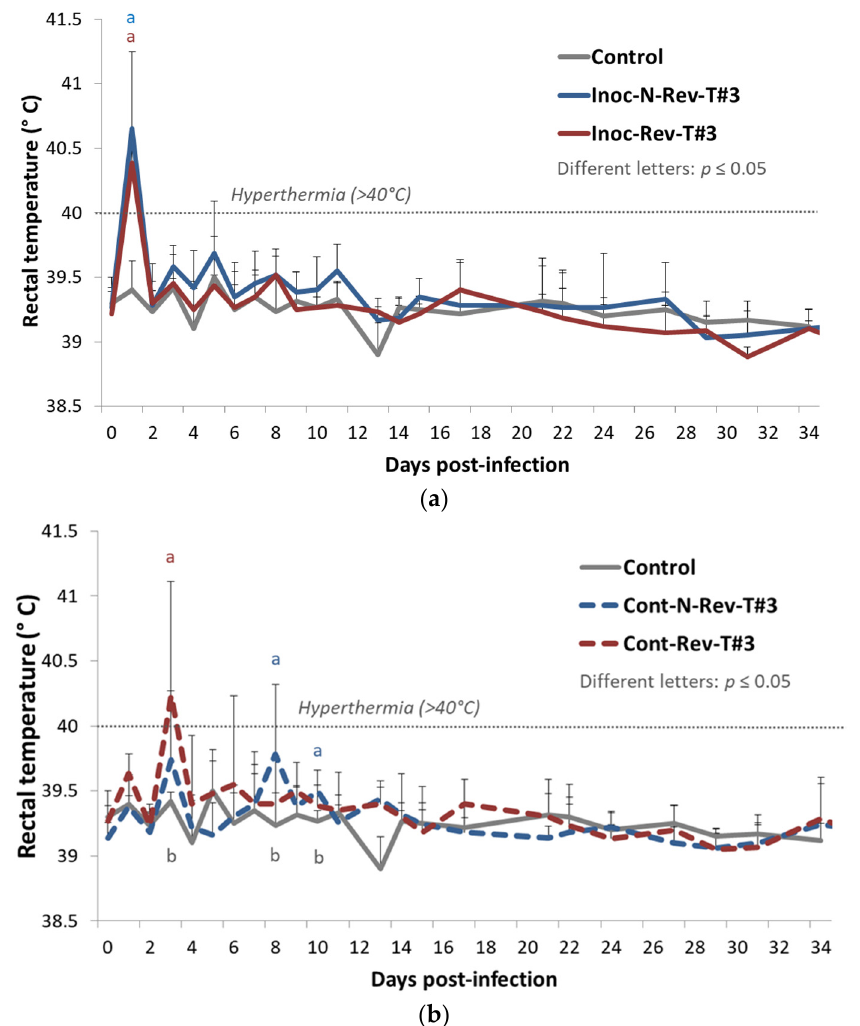
Figure 4. Evolution of the mean rectal temperatures (°C) in inoculated pigs ( a ) and contact pigs ( b ) after inoculation (day 0) during Trial#3. Different letters (“a” and “b”) indicate that the groups are significantly different from each other with p ≤ 0.05.